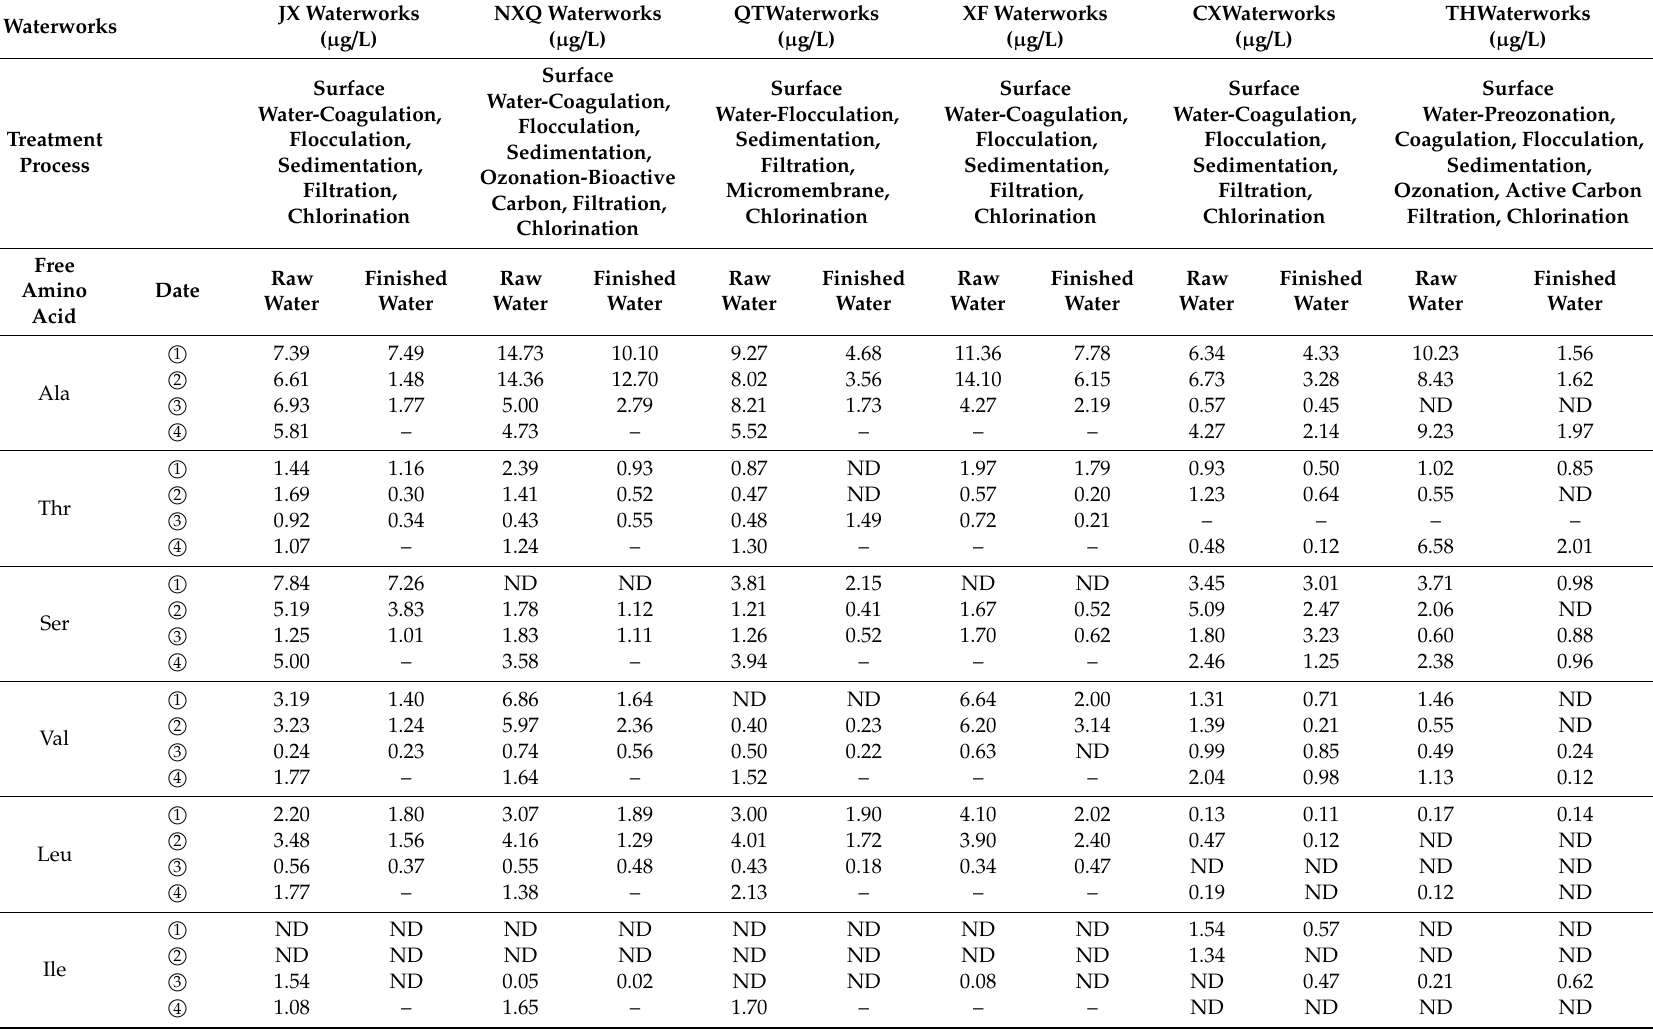
Table 5. The concentrations of various FAAs in drinking water treatment plants in Zhejiang